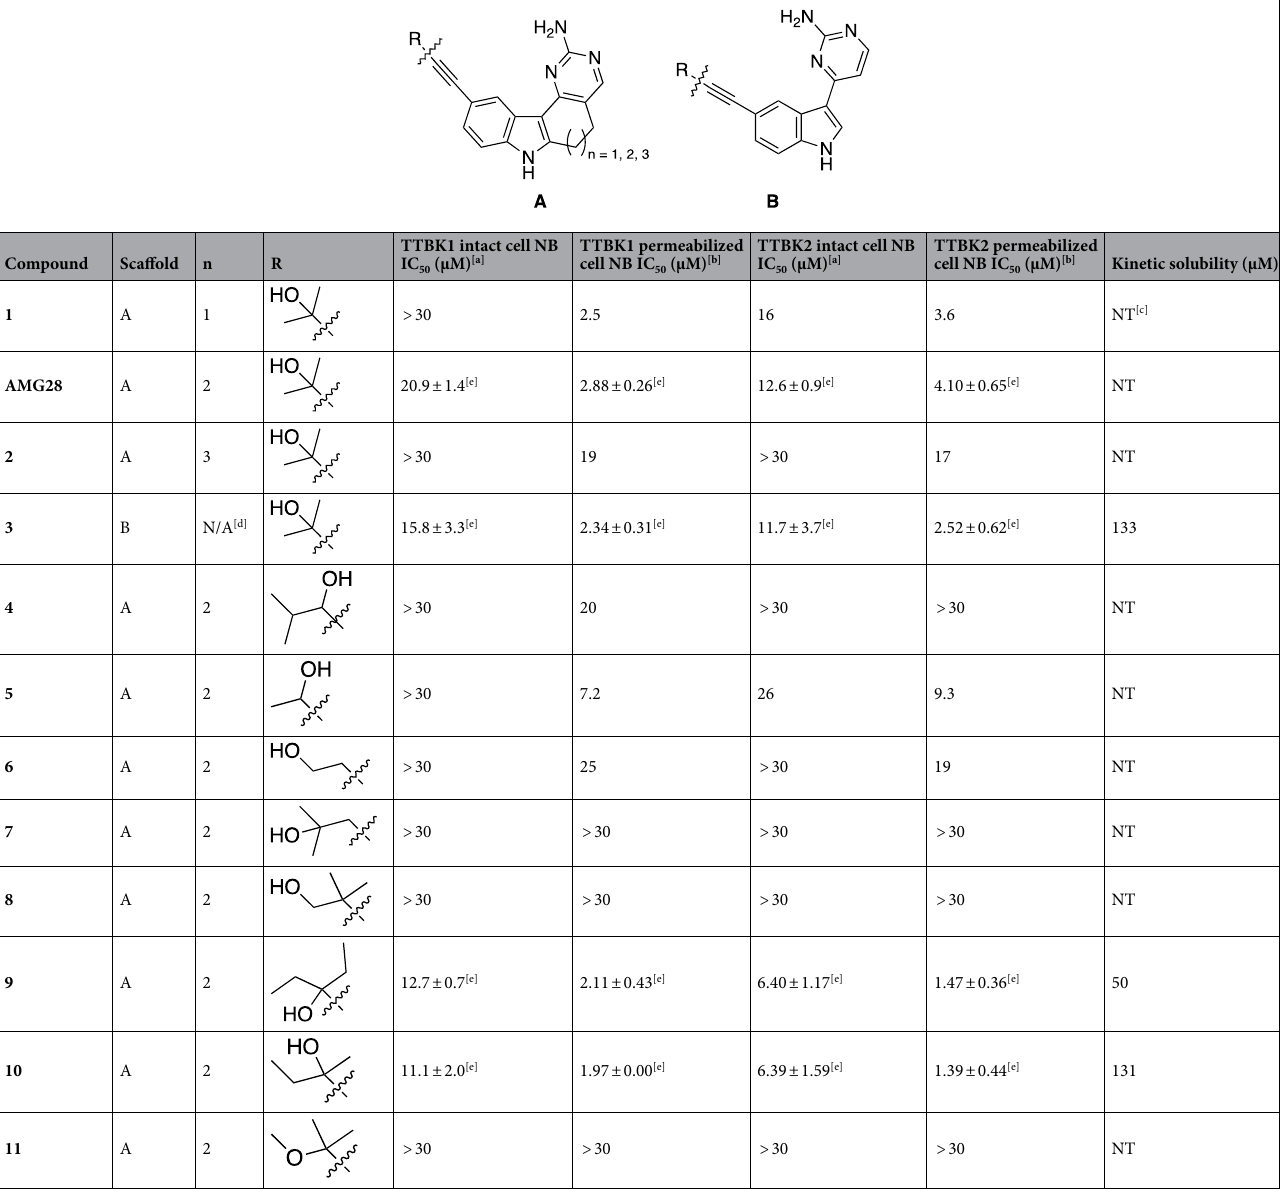
Table 2. NanoBRET and solubility data for Indolyl Pyrimidinamine Library a Assay executed in